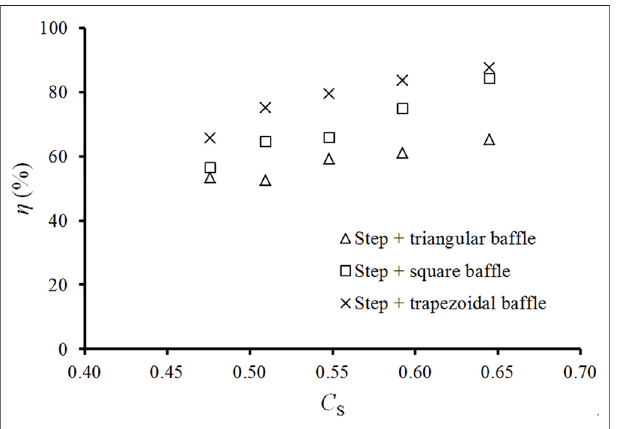
FIGURE8| Variationoftheenergydissipationratio κ withsolidfractionof the with incoming debris- fl ow.